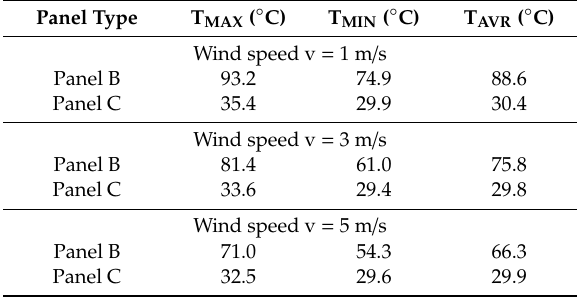
Table 5. Temperatures for the second series of tests.